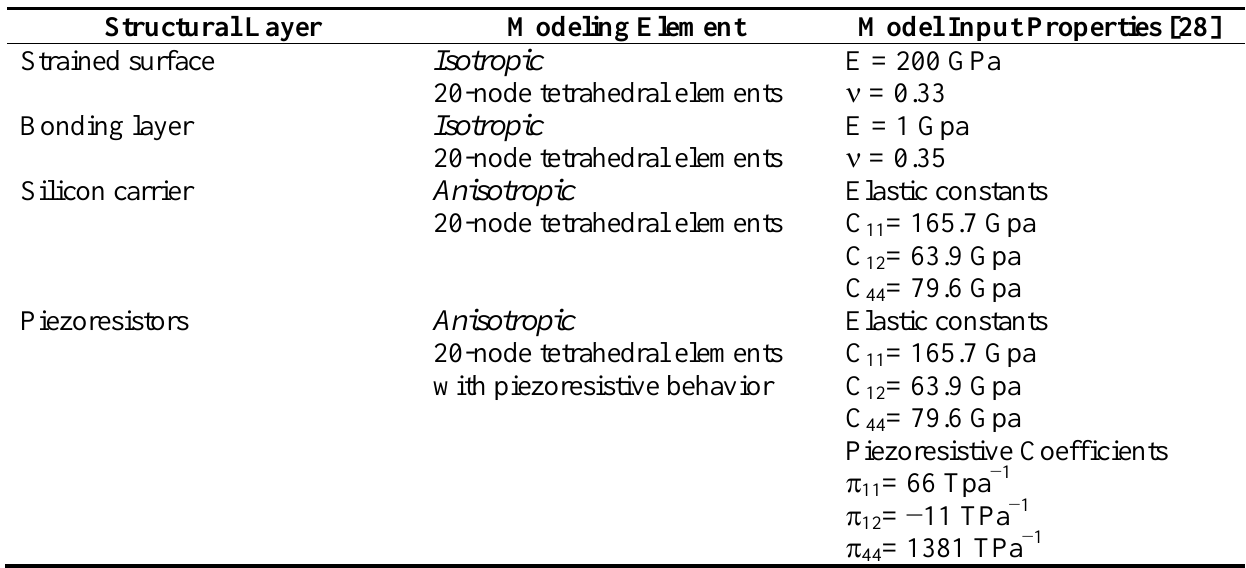
Table 1. Details of the FEA